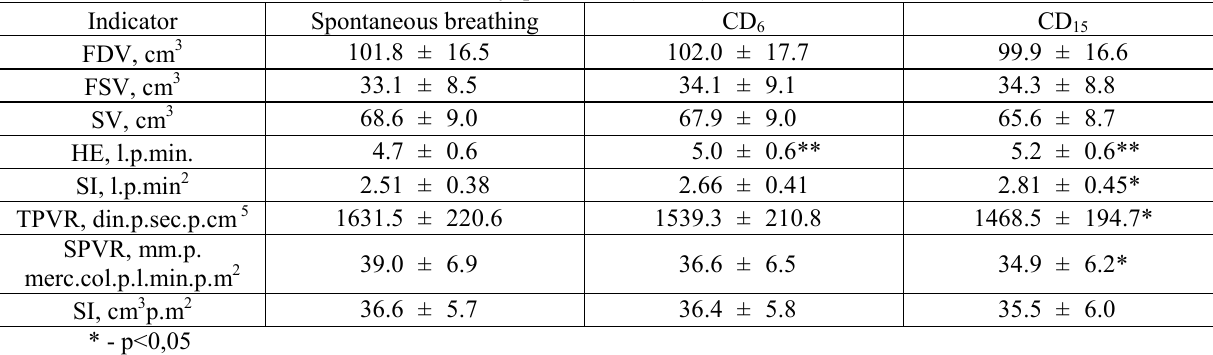
Changes of central haemo-dynamics’ indicators during tests CD 6 and CD 15 in comparison with spontaneous breathing of sportsmen